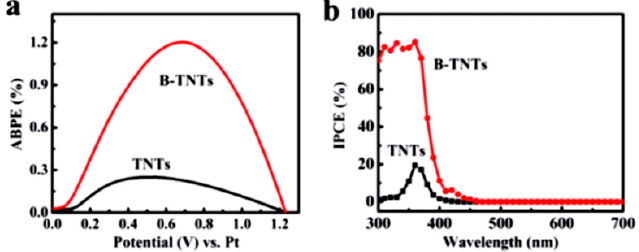
Figure 6. ( a ) Applied bias photon-to-current efficiency (ABPE) of the TiO 2 nanotubes (TNTs) and black titania nanotube (B-TNTs) as a function of applied potential; ( b ) incident-photon-to-current-conversion efficiency (IPCE) spectra in the region of 300–700 nm at 0.23 V vs . Ag/AgCl. Reprinted with permission from ref. [21]. Copyright 2014. The Royal Society of